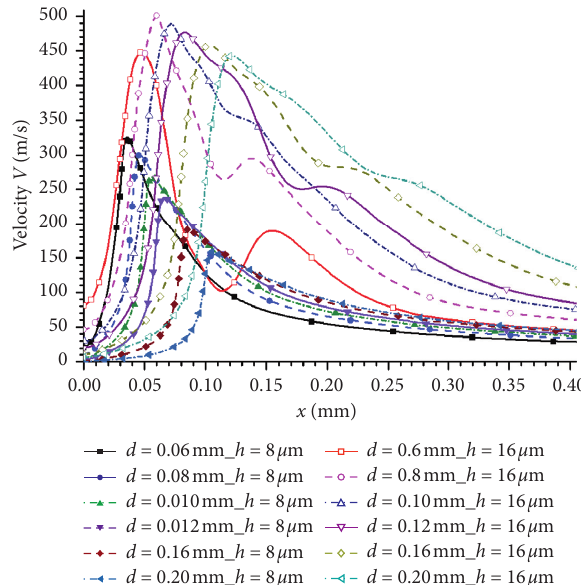
Figure 14: Curves D 2 of the velocity of the gas film at different d